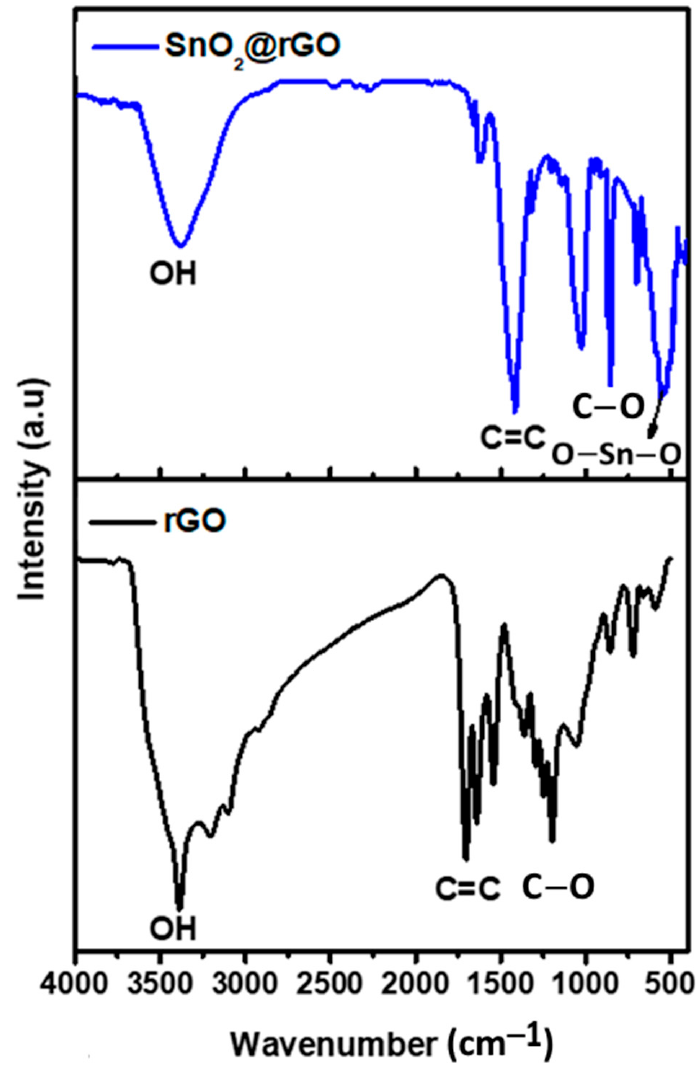
Figure 3. FTIR analysis of rGO nanosheet and SnO 2 @rGO nanocomposite.